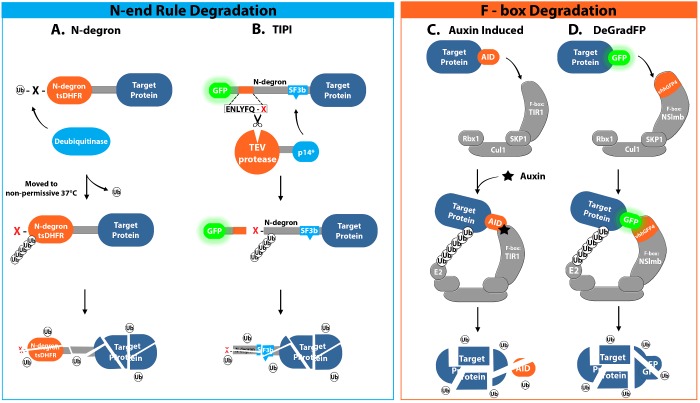
Illustration of methods for inducible protein degradation divided into those involving the N-end rule or F-box-based pathways(A) N-end degron method, involving the exposure of an unstable N-terminal amino acid which can be induced by a number of mechanisms including temperature- or small-molecule-based mechanisms. This unstable end is subsequently targeted for polyubiquitination by an E3 ligase, such as Ubr1P in yeast, and degraded via the proteasome pathway. (B) TIPI which utilizes TEV protease-mediated cleavage of a seven-amino-acid TEV recognition site to reveal an unstable N-terminal amino acid, subsequently targeted for proteasome-mediated degradation as for the N-end degron approach. The efficiency of TEV cleavage is increased by the inclusion of a short SF3b155381–424 domain downstream of the TEV recognition site, which binds to a mutant version of the human spliceosome subunit 14 (p14*) bringing p14*-TEV to the recognition site. (C) Illustration of the mechanism for auxin-induced degradation of target proteins tagged with an AID. Upon addition of auxin, the AID-tagged protein is recruited to an engineered E3 ubiquitin ligase SCF complex, containing the TIR1 F-box protein from plants, which binds target proteins in the presence of the plant hormone auxin. Expressing TIR1 in non-plant cells is enough to result in formation of the SCF complex which then binds AID-tagged proteins in an auxin-dependent manner, leading to polyubiquitination and degradation via the proteasome. (D) Schematic illustration of the deGradFP method for inducible protein degradation. The GFP-tagged target protein is recruited to an engineered SCF complex containing the F-box protein NSlmb conjugated to an anti-GFP single-chain antibody (vhhGFP4). Target protein is polyubiquitinated via the recruited E2 ubiquitin ligase and subsequently degraded via the endogenous proteasome machinery.